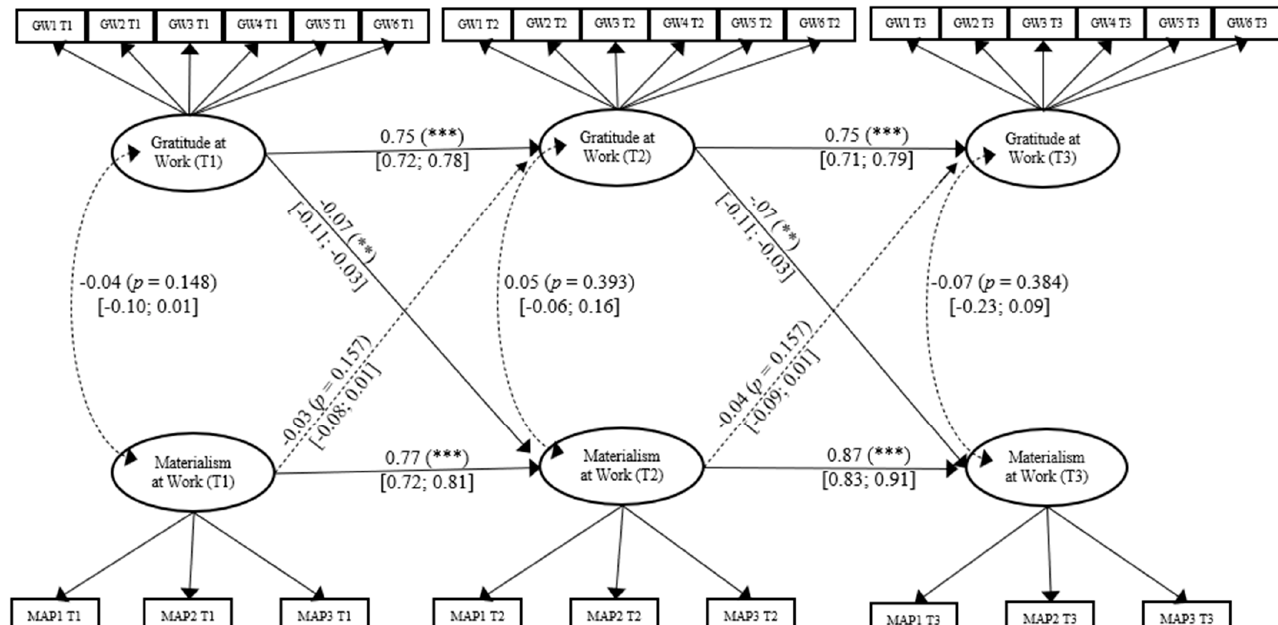
Figure 1. Model 1. Cross-lagged Panel Model for the Associations Between Materialism at Work and Gratitude at Work. χ 2 (304) = 1410.816, p < 0.001; CFI = 0.91; RMSEA = 0.04. Note. All coefficients shown are standardized path. Error terms and factor loadings are not shown to enhance visual clarity. Loadings range all between 0.33 to 0.89 ( p < 0.001). T1: Time 1; T2: Time 2; T3: Time 3. GWi: Gratitude at work item i. MAPi: Parcels materialism at work item i. Solid lines = significant paths, Dotted lines = no significant paths. Confident intervals are reported in square brackets. *** p < 0.001; ** p < 0.01; * p < 0.05.